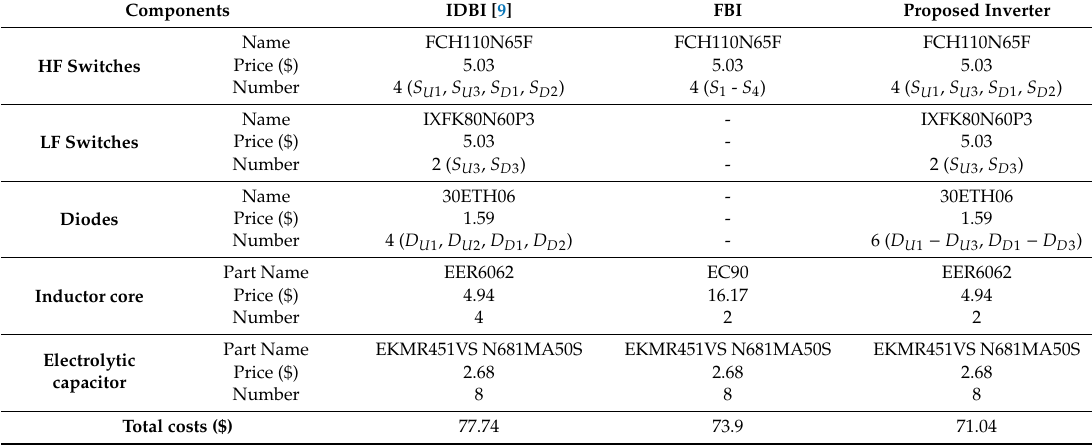
Table 3. Components for the experimental